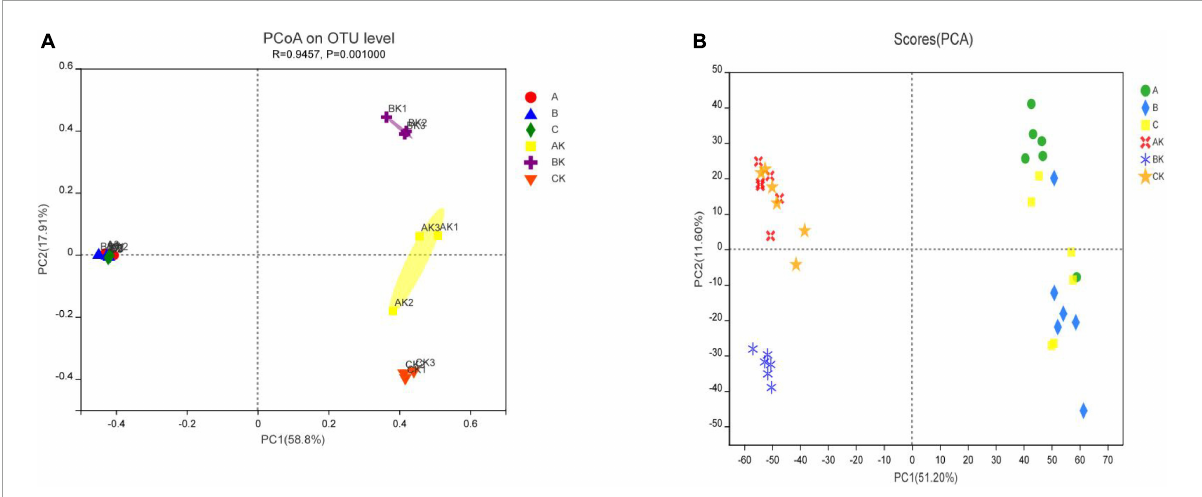
FIGURE1 The principal coordinate analysis (PCoA) plot showing variation in bacterial community structure of different harvests. (A) The principal component analysis (PCA) of metabolites showing variation among the different harvests of fresh and silage ryegrass. (B) Each point represents an individual. A, first harvest of fresh ryegrass; B, second harvest of fresh ryegrass; C, third harvest of fresh ryegrass; AK, First harvest of ryegrass silage; BK, second harvest of ryegrass silage; CK, third harvest of ryegrass